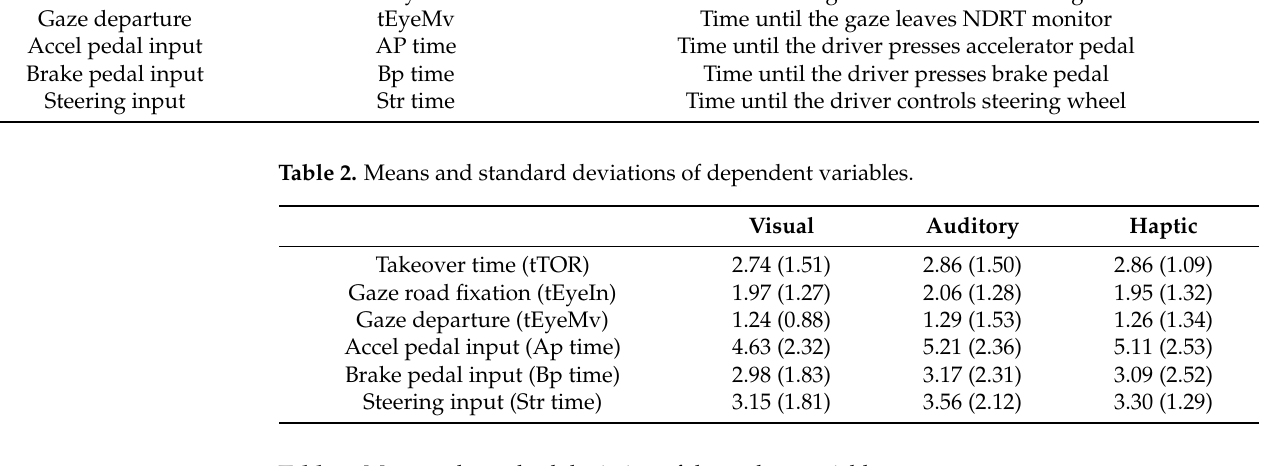
Table 3. Mean and standard deviation of dependent